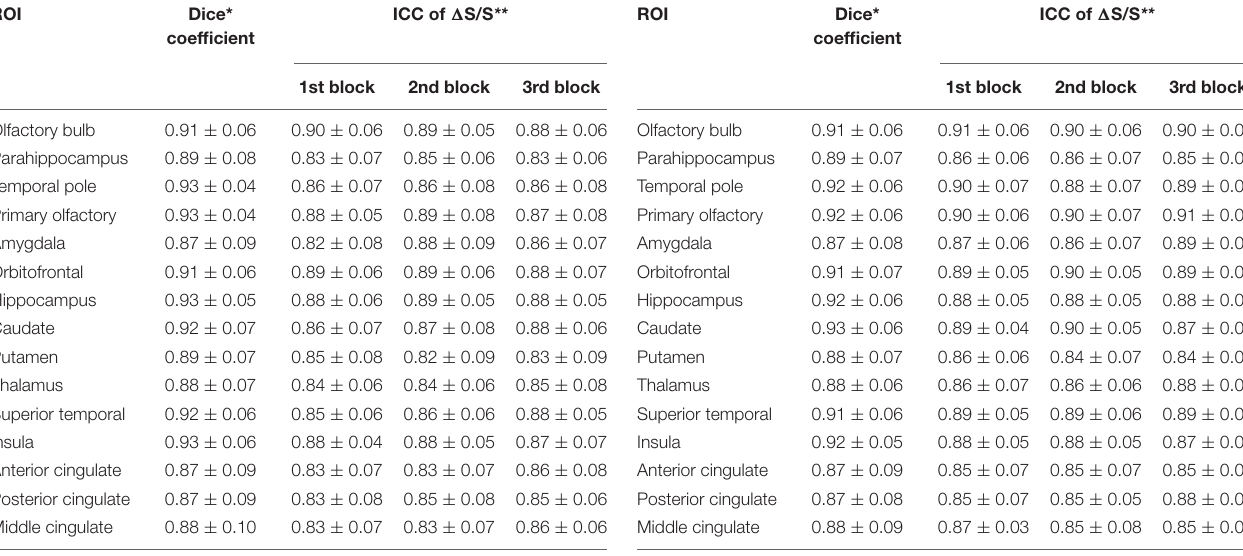
TABLE 5 | Reproducibility for negatively activated voxels in T2prep BOLD fMRI ( n = 14). ROI Dice*